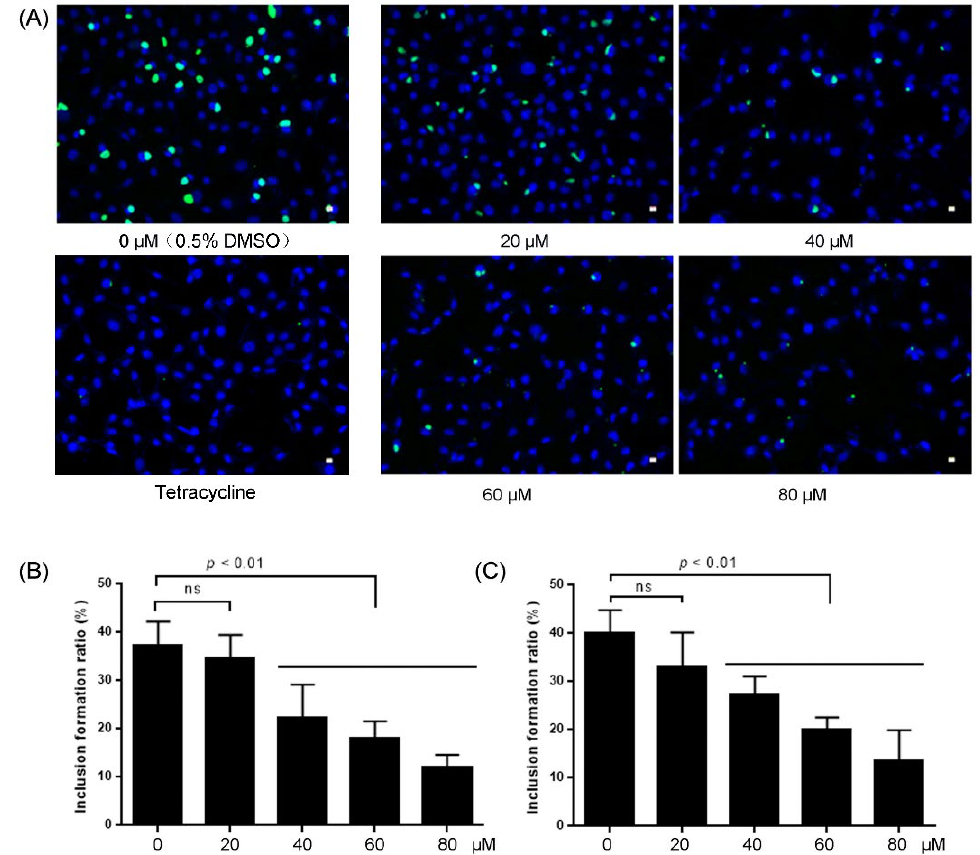
Figure 4. Dose-dependent antichlamydial effects of compounds 1 and 2 . Chlamydia abortus strain GN6 cultured in McCoy cells were treated with various concentrations of compound 1 or 2 . Tetracycline (final concentration of 5 μM) was used as a positive control. The chlamydial inclusions were visualized by immunofluorescent staining, and the inclusion formation ratio was utilized to represent the antichlamydial activities. ( A ) Chlamydia abortus inclusions were smaller in size and less in number in cell cultures treated with compound 1 . ( B ) A significant reduction of the inclusion formation ratio of Chlamydia abortus in cell cultures treated with compound 1 . ( C ) A significant reduction of the inclusion formation ratio of Chlamydia abortus in cell cultures treated with compound 2 . ns, no significant difference; p < 0.01, significant